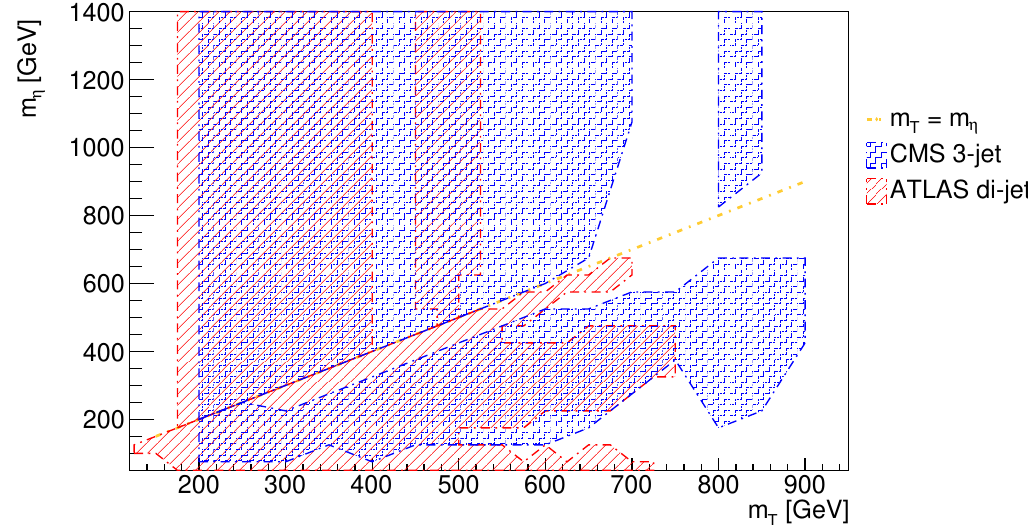
Figure 5. The CMS and ATLAS bounds on the fully hadronic decay mode (to light jets) of the top partner. The shaded regions are excluded by the current searches conducted at the LHC [49,